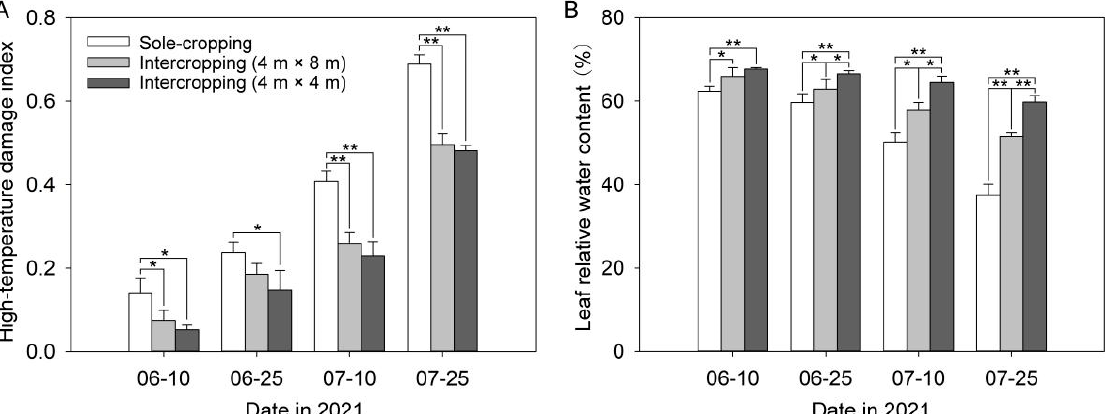
Figure 1. Effects of understory cultivation on high-temperature damage index and leaf relative water content of P. ostii : ( A ) high-temperature damage index; ( B ) leaf relative water content. Values represent mean ± SDs, and * or ** indicate significantly lower or higher among the sole-cropping P. ostii and intercropping P. ostii under C. illinoinensis with row spacing of 4 m × 8 m and of 4 m × 4 m according to Duncan’s multiple range test (* p < 0.05, ** p < 0.01).